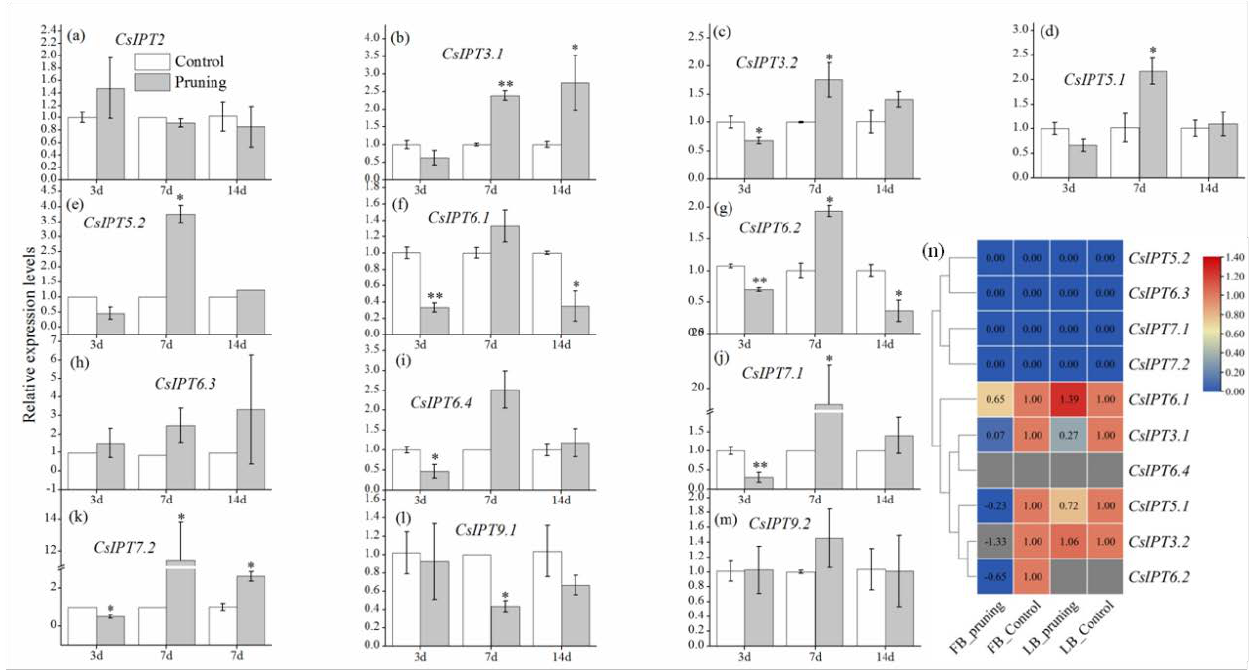
Figure 7. Expression profiles of CsIPT genes in the flower-bud and leaf-bud that were induced by pruning. The expression profiles of CsIPTs in the flower-bud that were detected by qRT-PCR at different time points after pruning ( a-m ). The expression profiles of CsIPTs in the flower-bud and leaf-bud that were detected by RNA-seq at different time points after pruning ( n ). In each figure, asterisks show marked difference in the expression levels of CsIPT gene between control and pruning (**P <0.01; Student’s t -test).